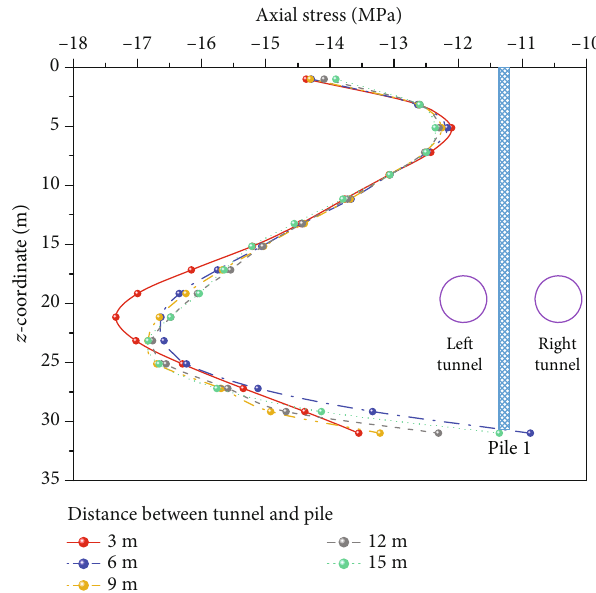
Figure 16: Axial displacements of Pile 1 on completion of twin tunneling at di ff erent pile-to-tunnel distances.